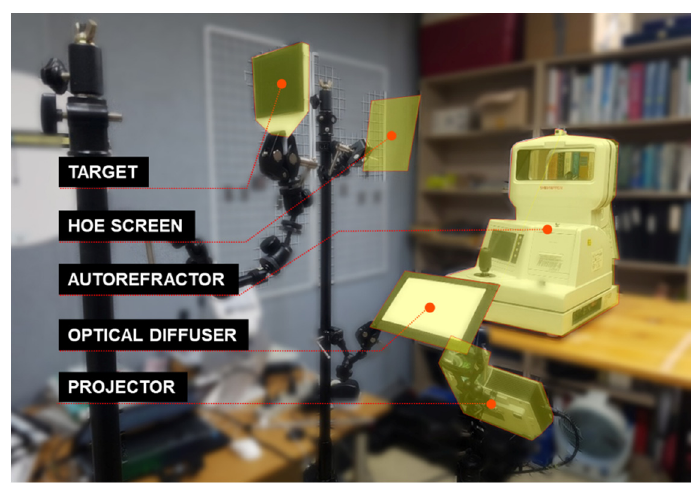
Figure 8. Real system model for accommodative response measurement.